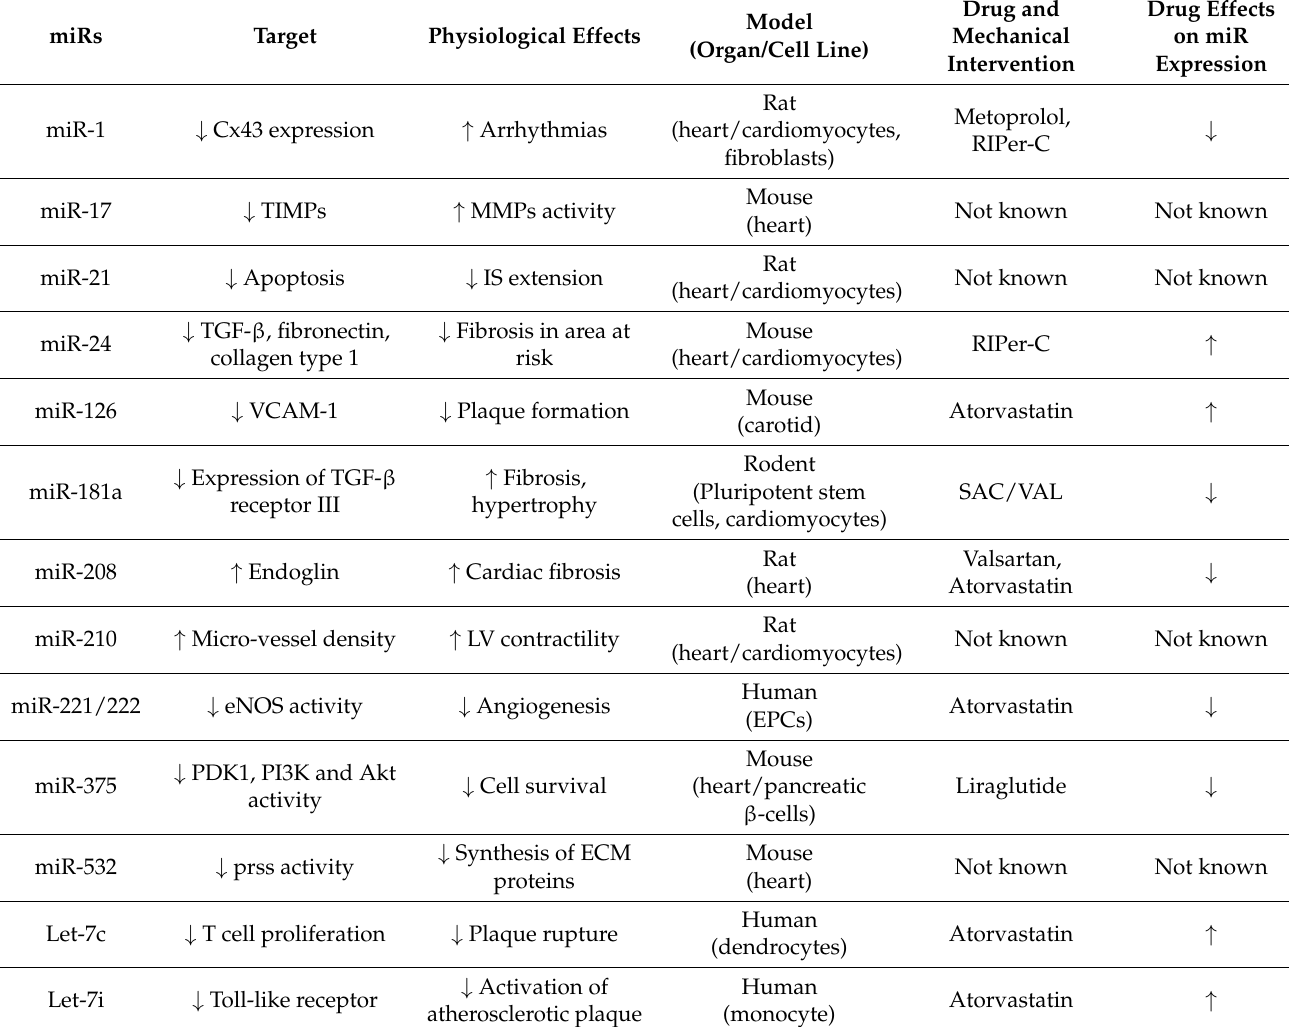
Table 1. Principal miRs involved in post-AMI LVR phenomenon. For each miR, the actions on selective molecular targets, the determined physiological effects, and experimental models (organ/cell lines) that were used are indicated. Furthermore, drugs or mechanical interventions selectively modulating the expression of each miR are reported. miRs: micro-RNAs; AMI: acute myocardial infarction; LVR: left ventricular remodeling; Cx43: connexin43; TIMPs: tissue inhibitor of metalloproteinases; TGF- β : tumor growth factor- β ; VCAM-1: vascular cell adhesion molecule-1; eNOS: endothelial nitric oxide synthase; MMPs: metalloproteinases; IS: infarct size; LV: left ventricle; ECM: extra-cellular matrix; EPCs: endothelial progenitor cells; RIPer-C: remote ischemic perconditioning; SAC/VAL: sacubitril/valsartan. ↑ indicates an increase; ↓ indicates a